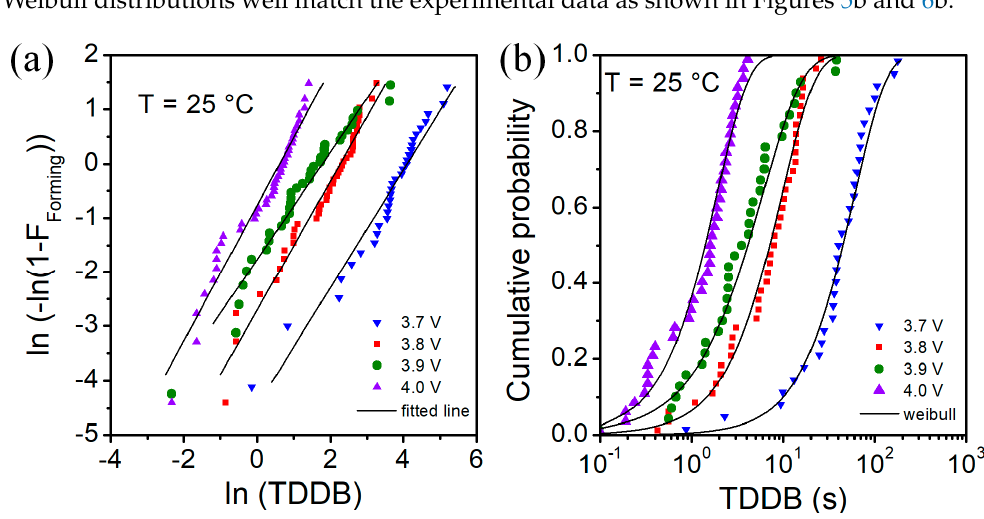
Figure 5. Weibull plot ( a ) and distribution ( b ) of time to breakdown for different values of voltage stress at room T = 25 °C.